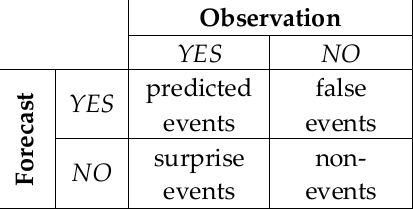
Figure 1. Contingency table for a dichotomous categorical verification of forecasts.